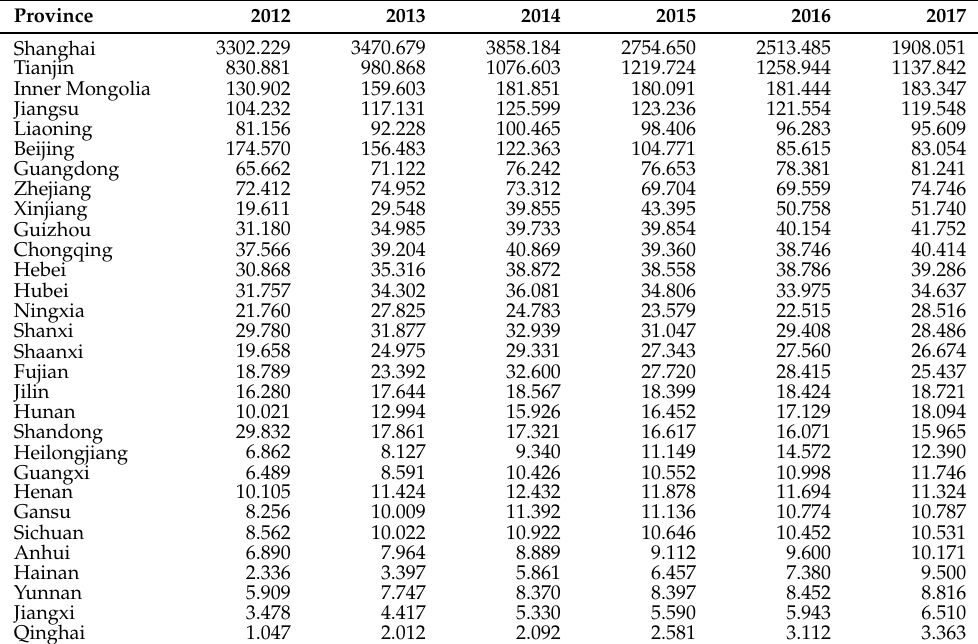
Table A9. The intra-provincial carbon inequality estimation results of original carbon emission data based on a 4-year rolling window for 30 provinces in China from 2012 to 2017.